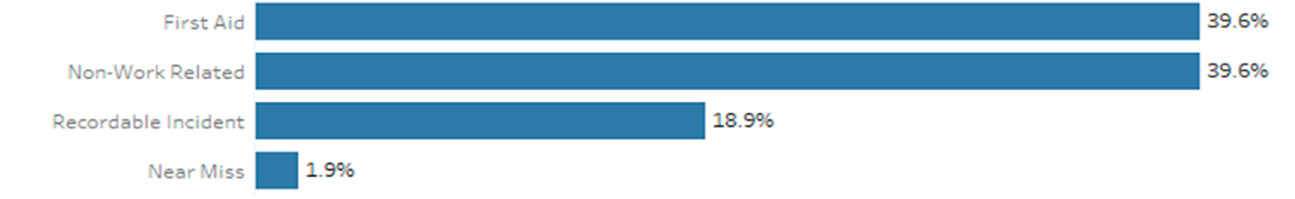
Figure 1. Injuries sorted by original classification.